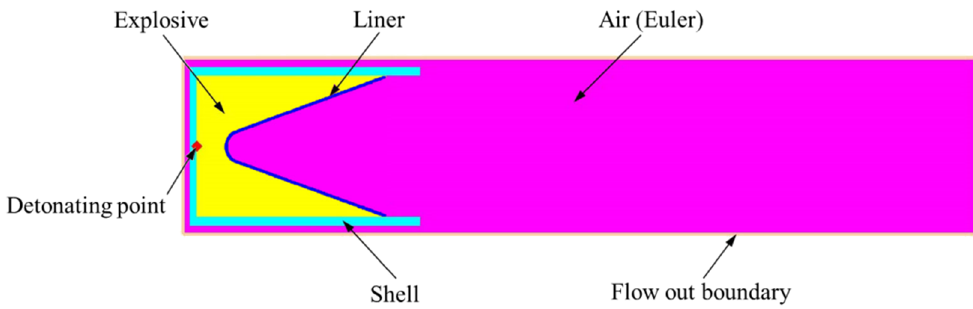
Figure 1. The finite element model.